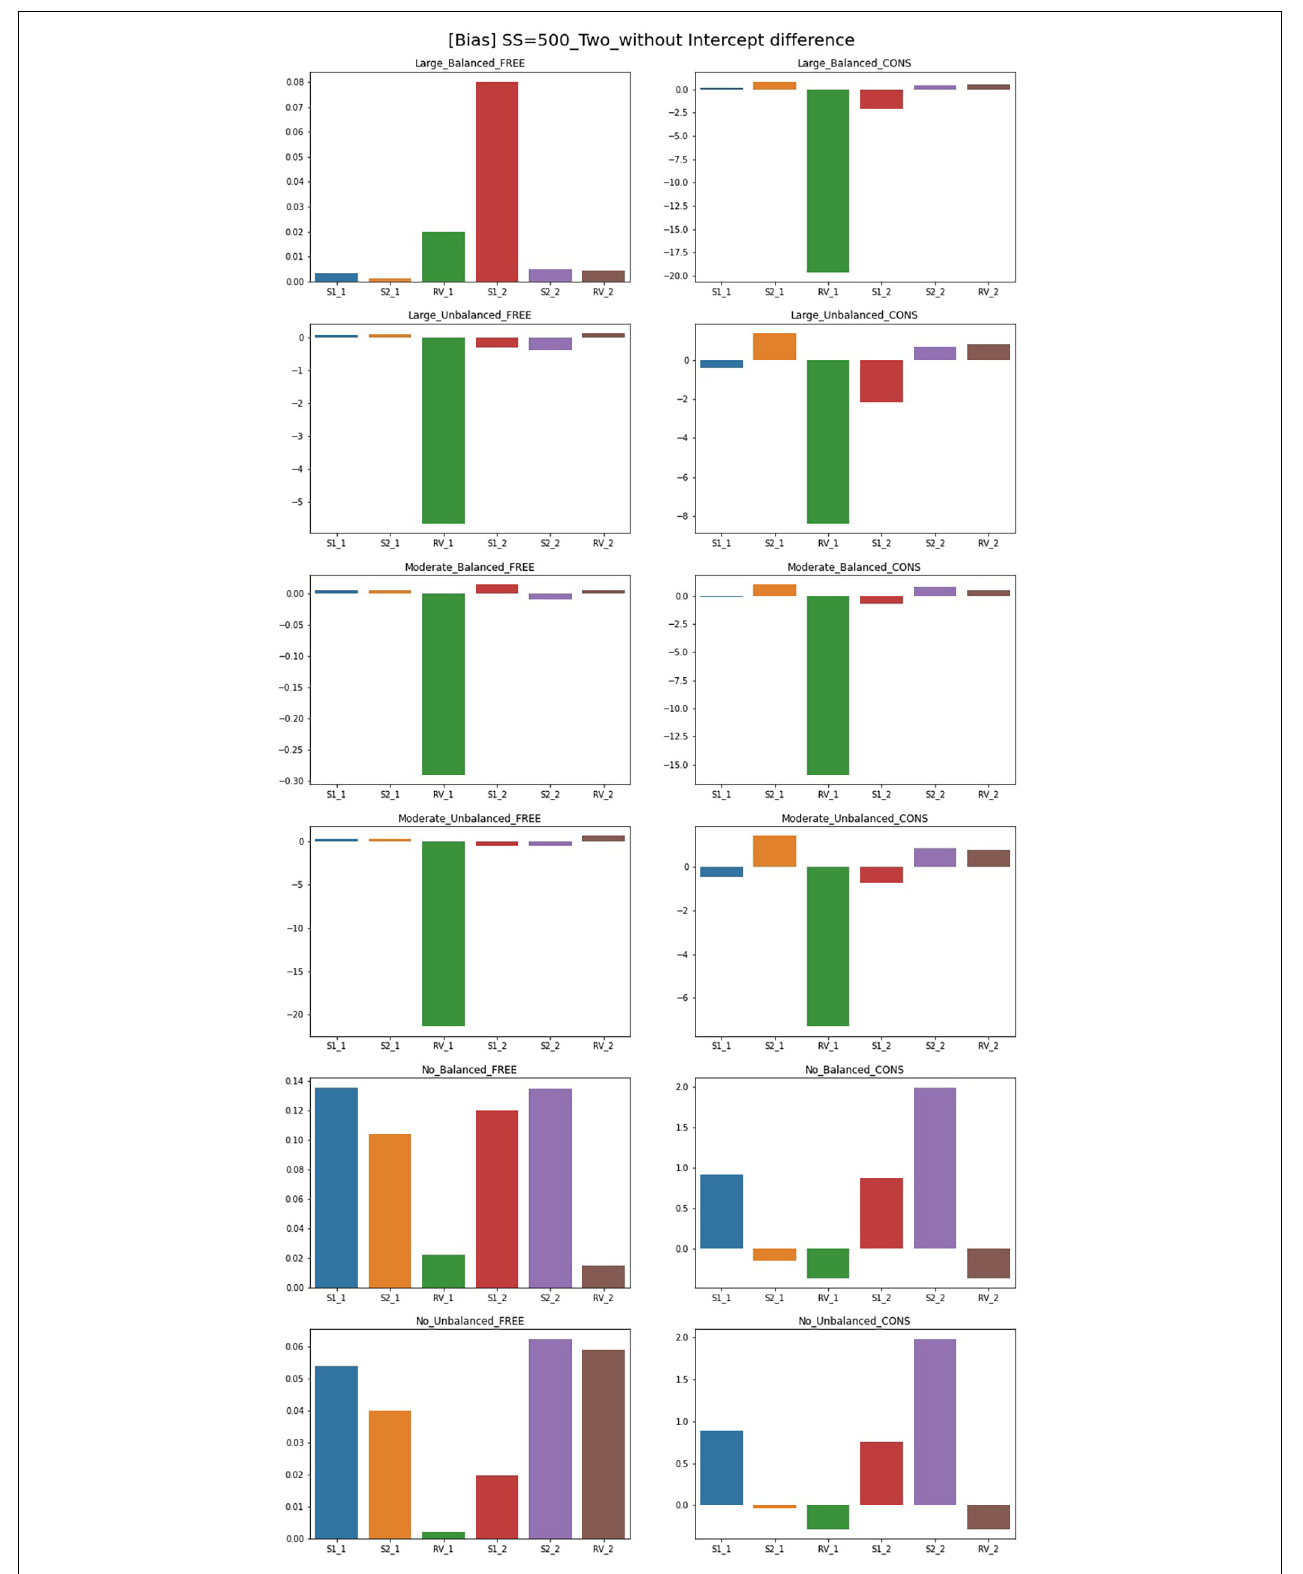
FIGURE 3 | Parameter bias of two-predictor models (sample size = 500, without intercept difference). Free, residual variances freely estimated; Cons, residual variances equally constrained; S_1, slope for class 1; RV_1, residual variance for class 1; S_2, slope for class 2; RV_2, residual variance for class 2.